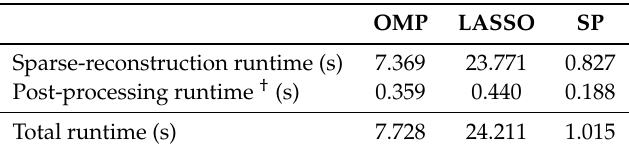
Table 3. Average runtime performance.